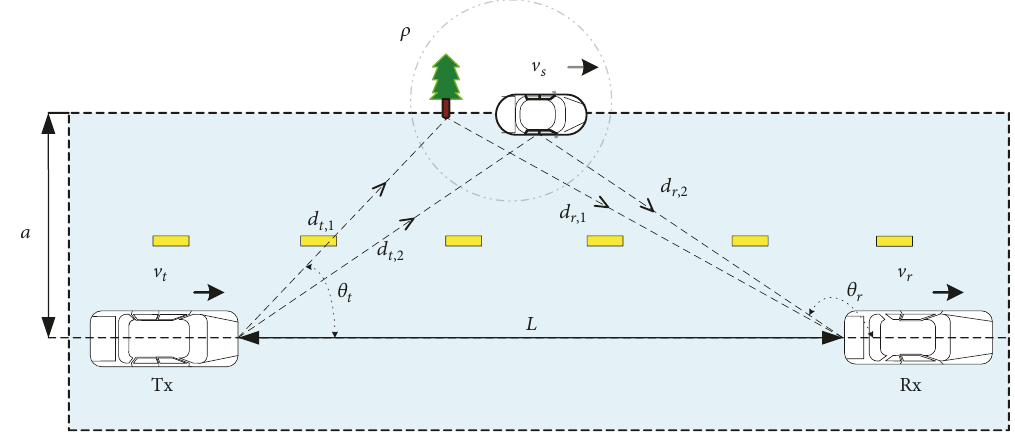
Figure 5: Real-world propagation scenario with one cluster between Tx and